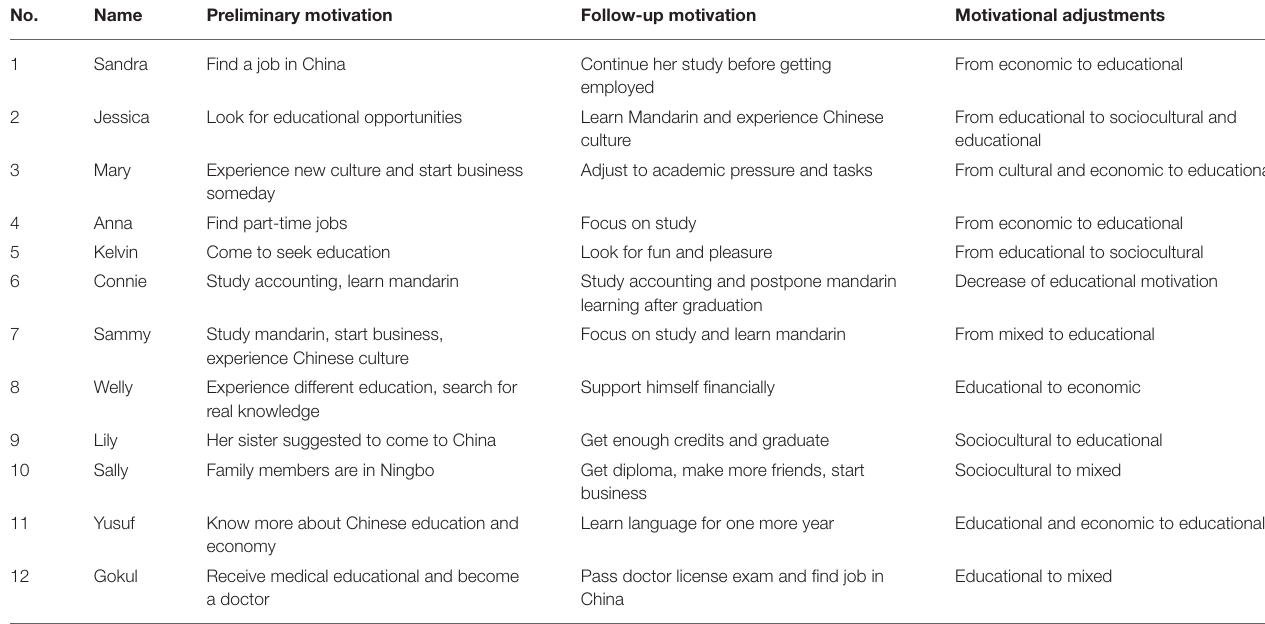
TABLE 5 | Cases of motivational adjustments among international students in China.